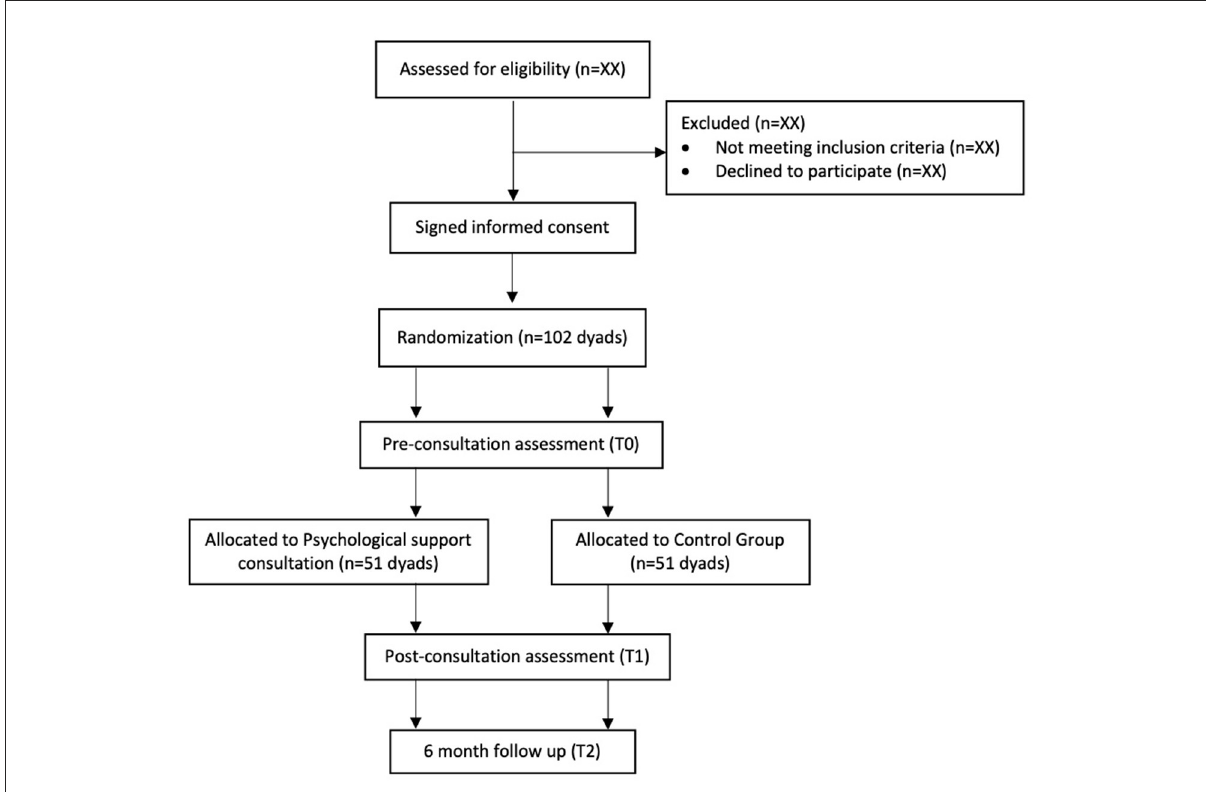
FIGURE1 Study protocol